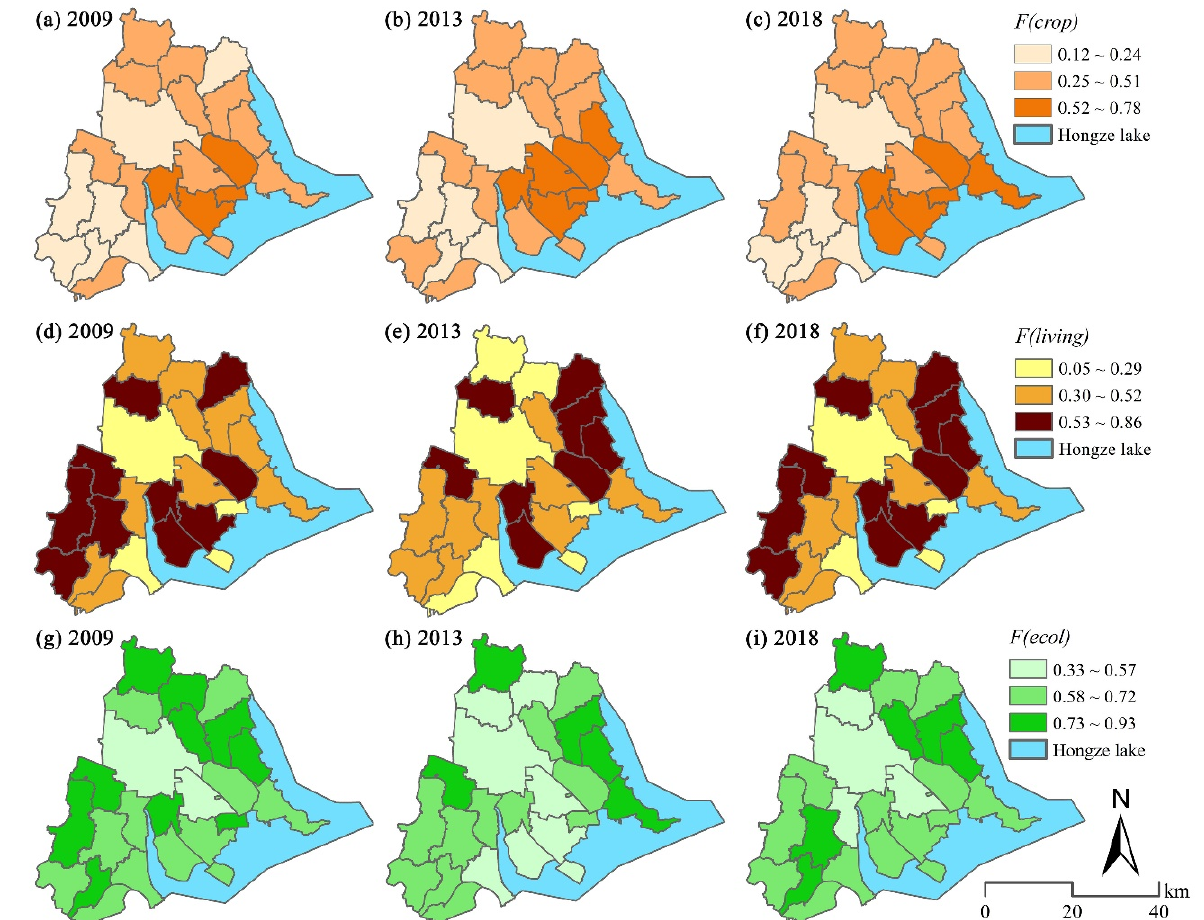
Figure 7. Changes in the farmland function in Sihong from 2009 to 2018.